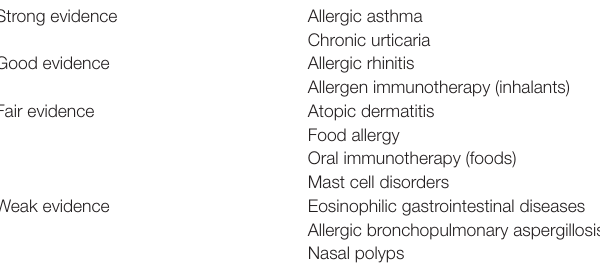
TABLe 1 | Clinical benefit with omalizumab